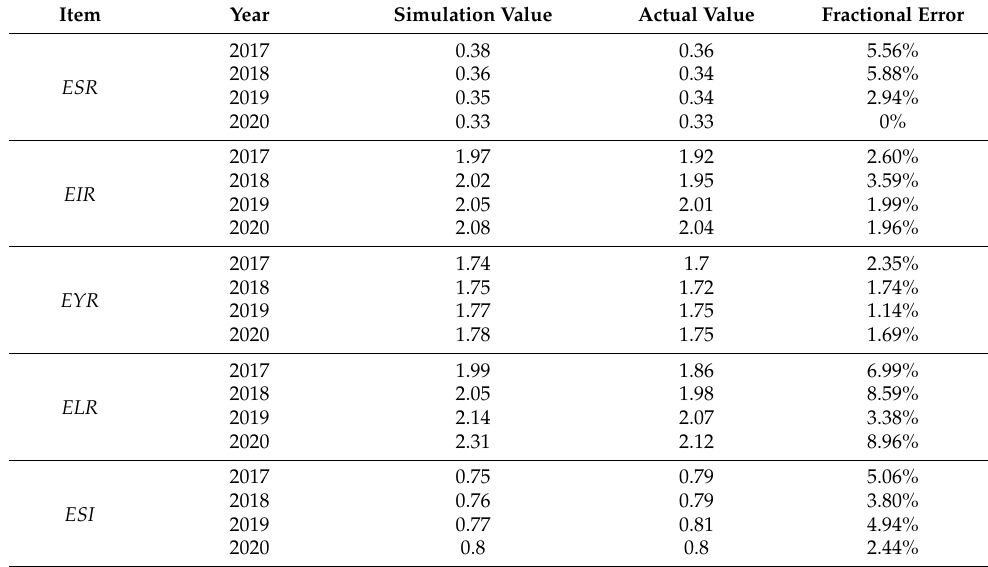
Table 8. Dynamic emergy prediction model